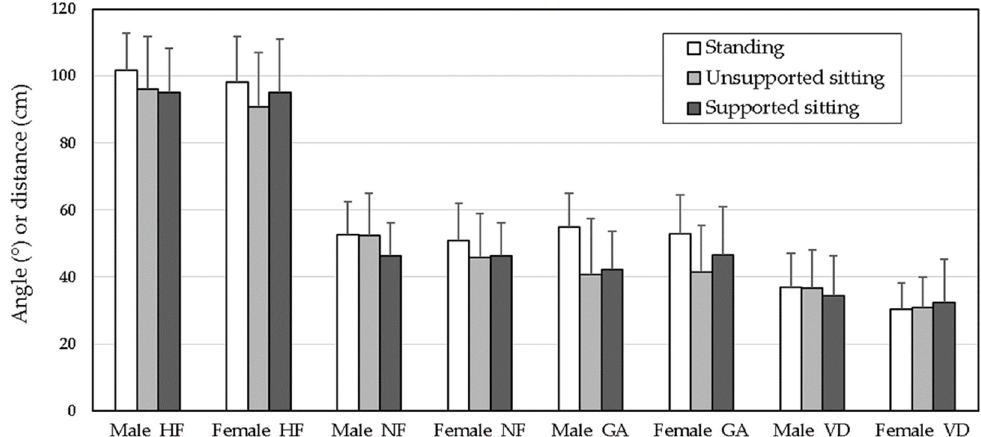
Figure 3. Comparison of measured angles and distances for various gender and posture combinations (HF, head flexion; NF, neck flexion; GA, gaze angle; VD, viewing distance).